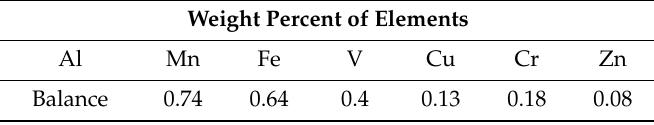
Table 1. Chemical composition of recycled aluminum.